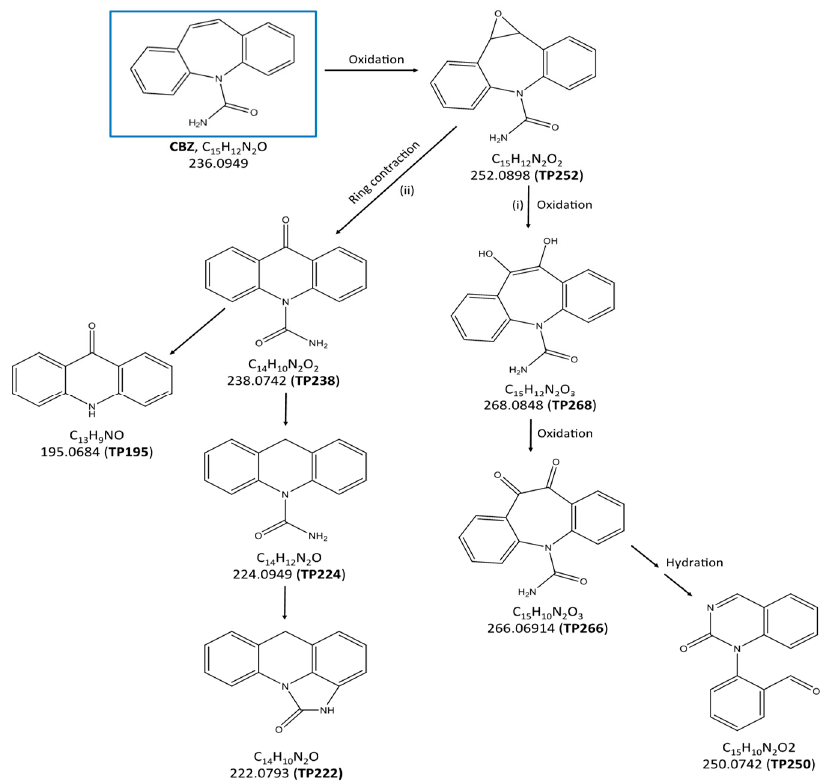
Figure 6. Proposed degradation pathway of carbamazepine degradation by photolysis obtained on the basis of the identified TPs.